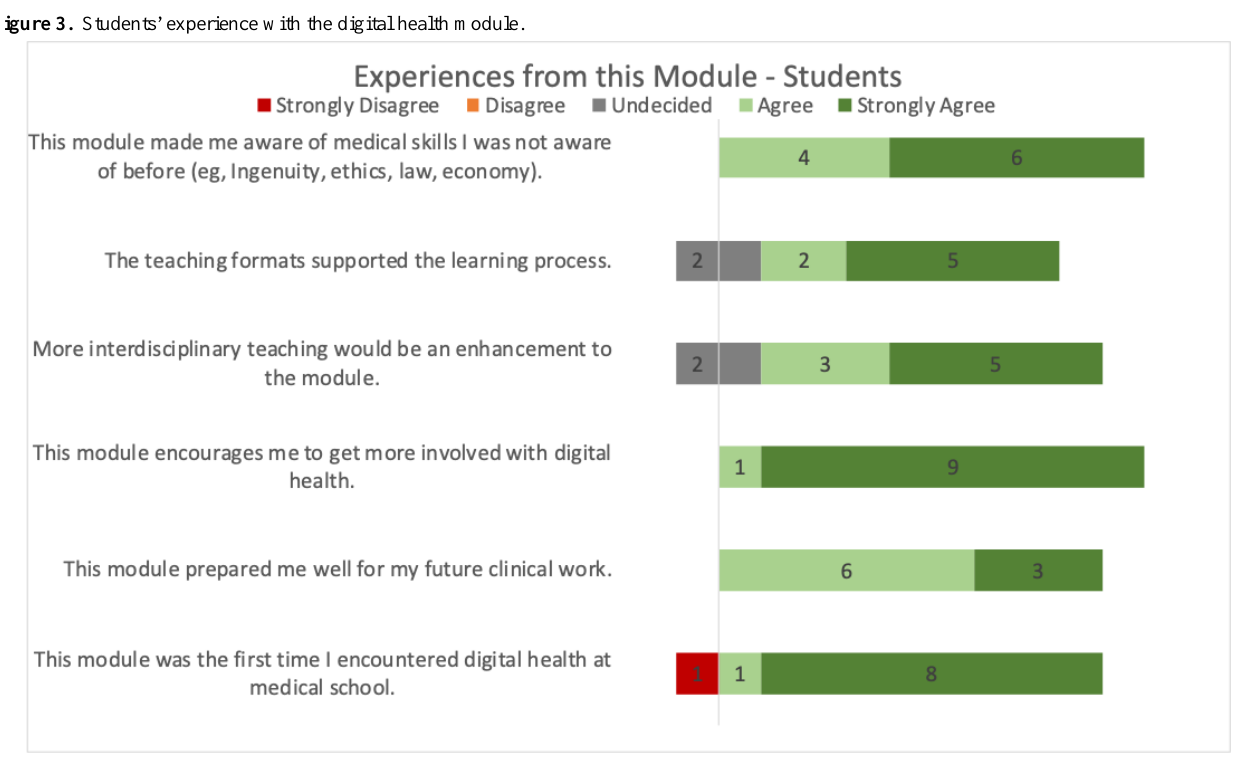
Figure 3. Students’experience with the digital health